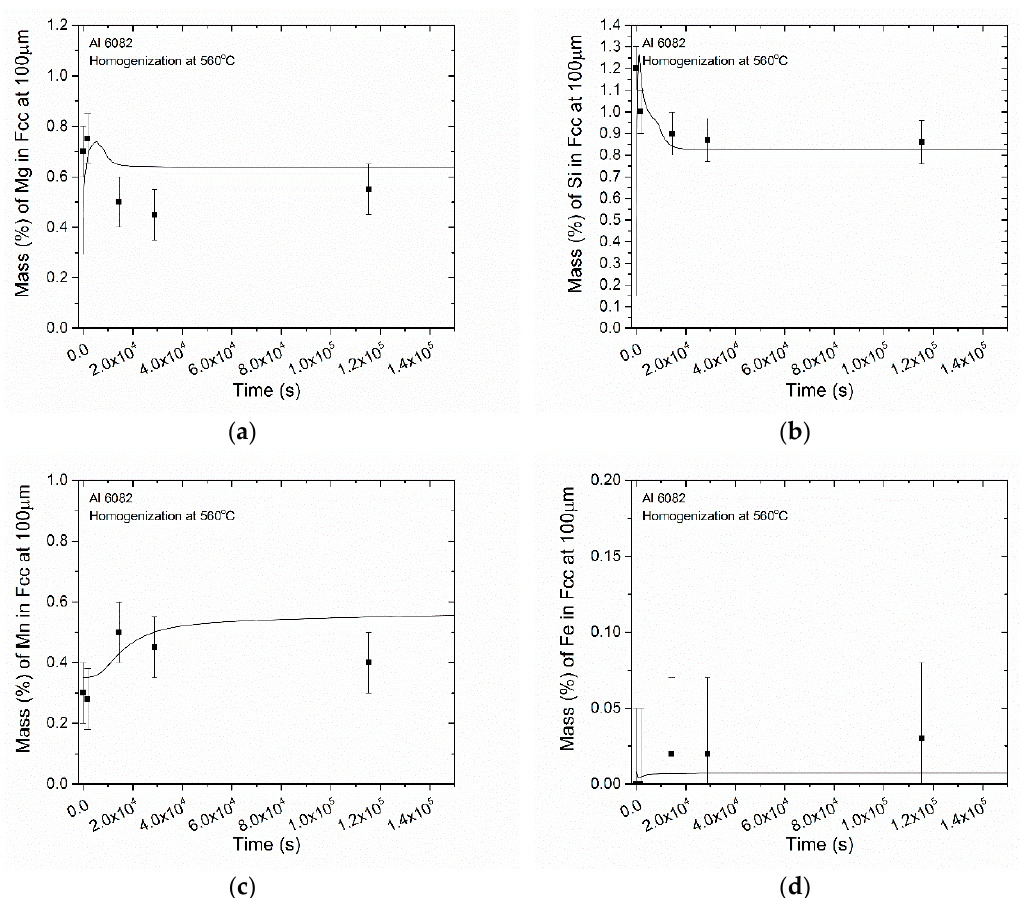
Figure 11. Comparison of DGM model prediction with EDS experimental data regarding the evolution of matrix concentration adjacent to the boundary during homogenization of 6082 alloy, ( a ) Mg, ( b ) Si, ( c ) Mn, ( d ) Fe.